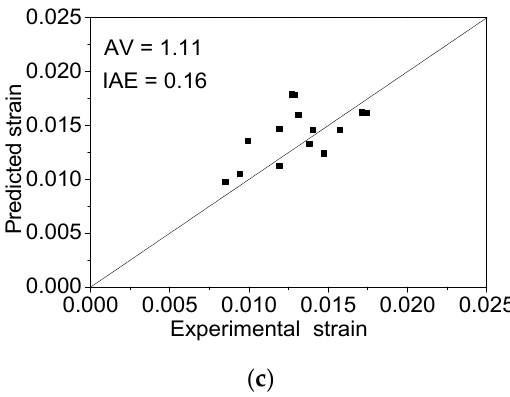
Figure 11. The performance of the ultimate stress and strain model for FRP confined elliptical columns. ( a ) Proposed ultimate stress model; ( b ) Teng and Lam’s ultimate stress model [32]; ( c ) proposed ultimate strain model.